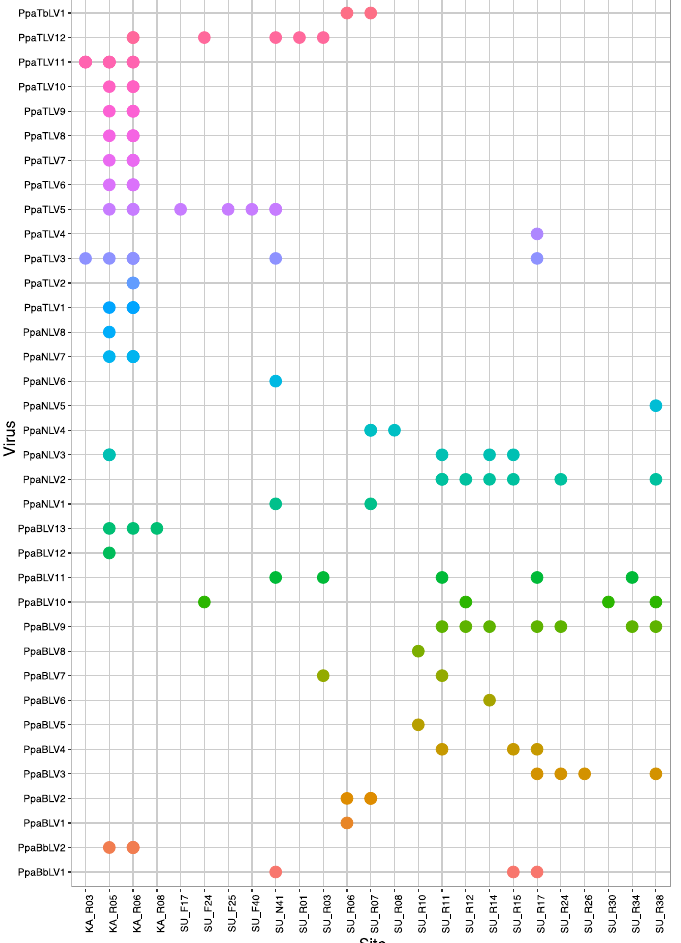
Figure 9. Plot representing the virus occurrence and diversity for each sampling site.